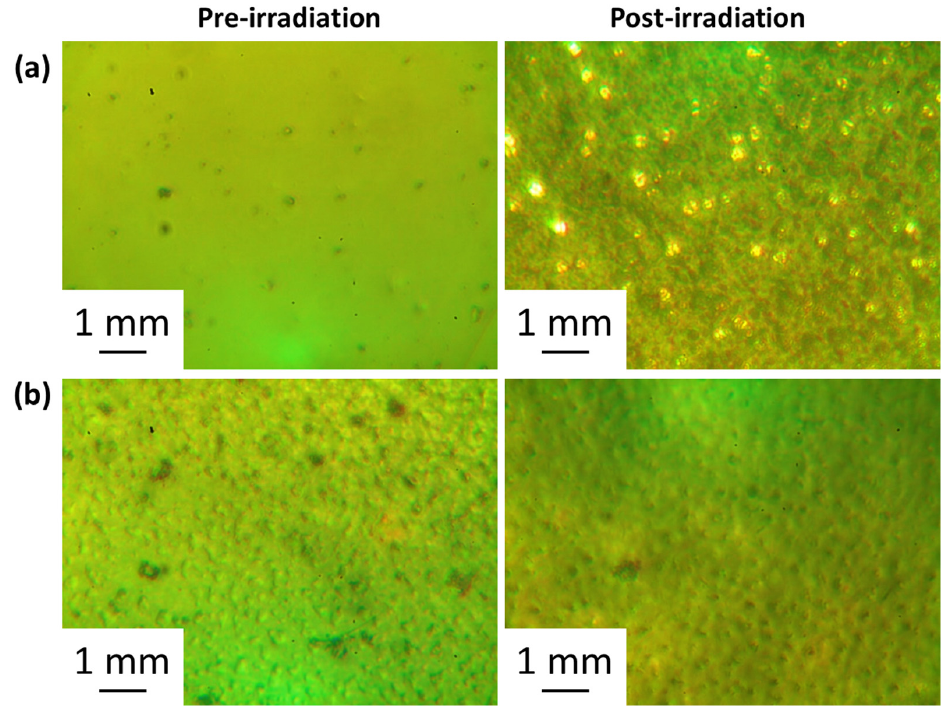
Figure 6. Pre- and post-irradiation (300 h) microscopy images of the films of ( a ): pure PVC and ( b ): PVC containing clotrimazole.